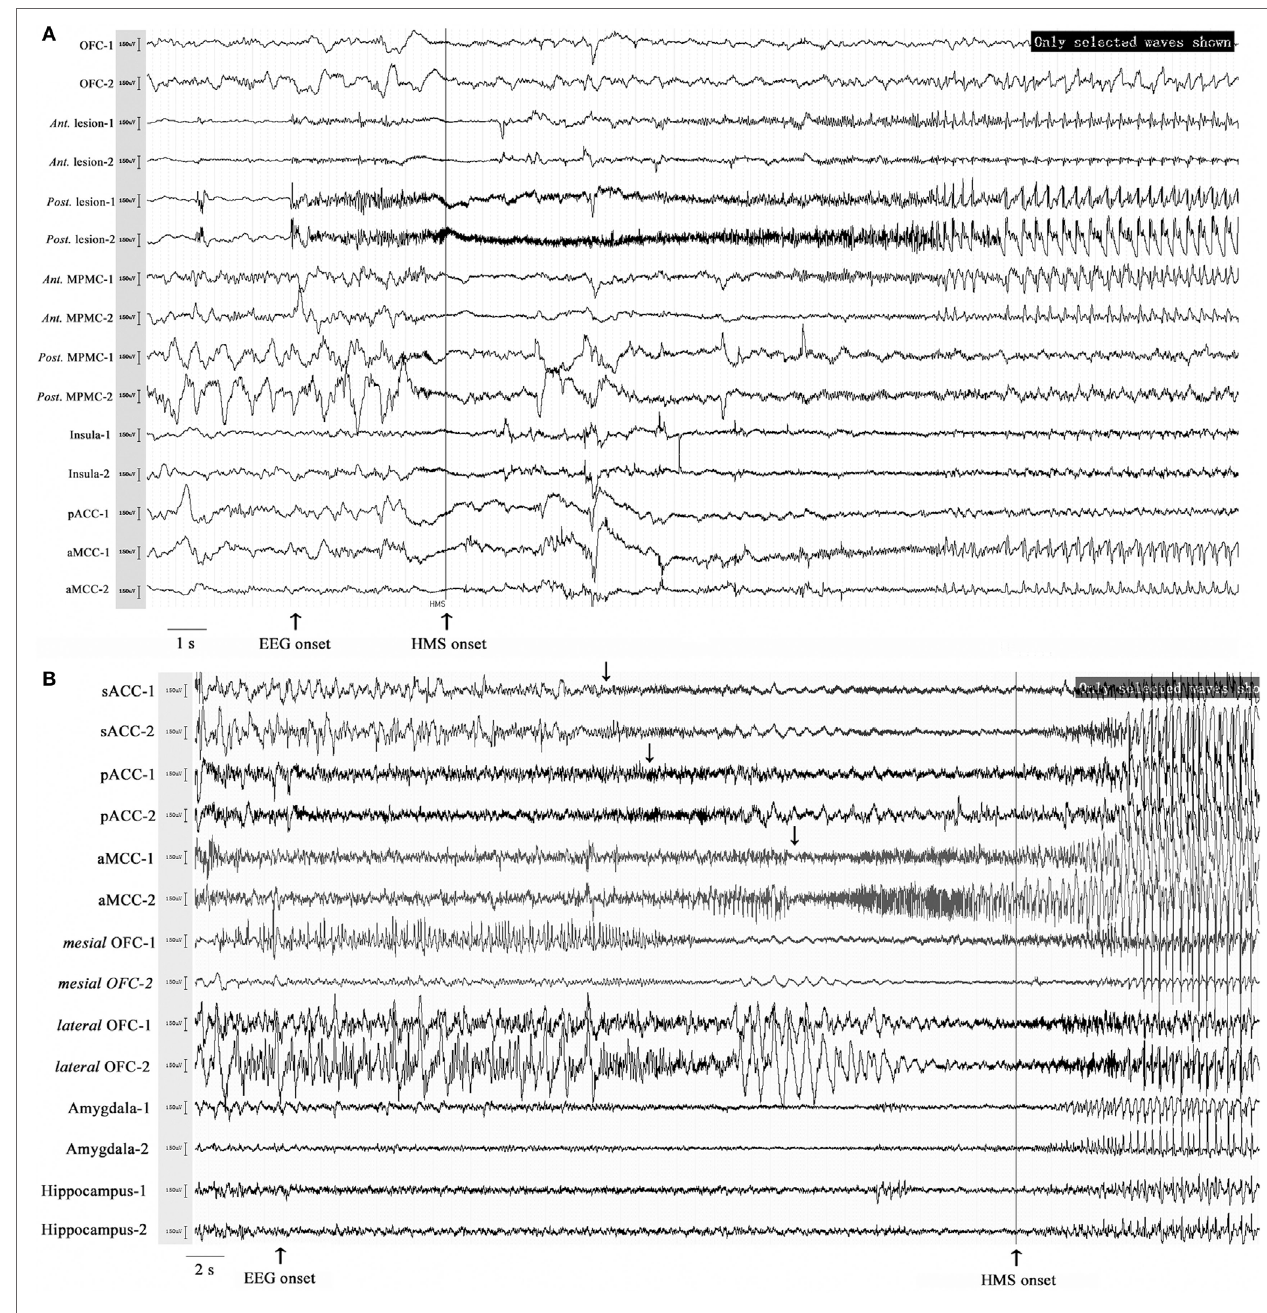
FigUre 5 | Stereo-electroencephalography recordings and hypermotor seizure (HMS) occurrence. In patient HMS1-5 (a) , ictal onset discharge originated from a dysplastic lesion in the anterior portion of the superior frontal sulcus, then spread to the mesial premotor cortex, insula, anterior cingulate cortex and MCC, and HMS occurred within a short time after electroencephalography (EEG) onset. In patient HMS1-6 (b) , orbitofrontal cortex (OFC) (contact: mesial OFC-1) was the epileptogenic focus. The ictal discharge spread along the subgenual anterior cingulate cortex (sACC)–pregenual anterior cingulate cortex (pACC)–anterior MCC (aMCC) ( black arrow ), and thereafter, HMS occurred